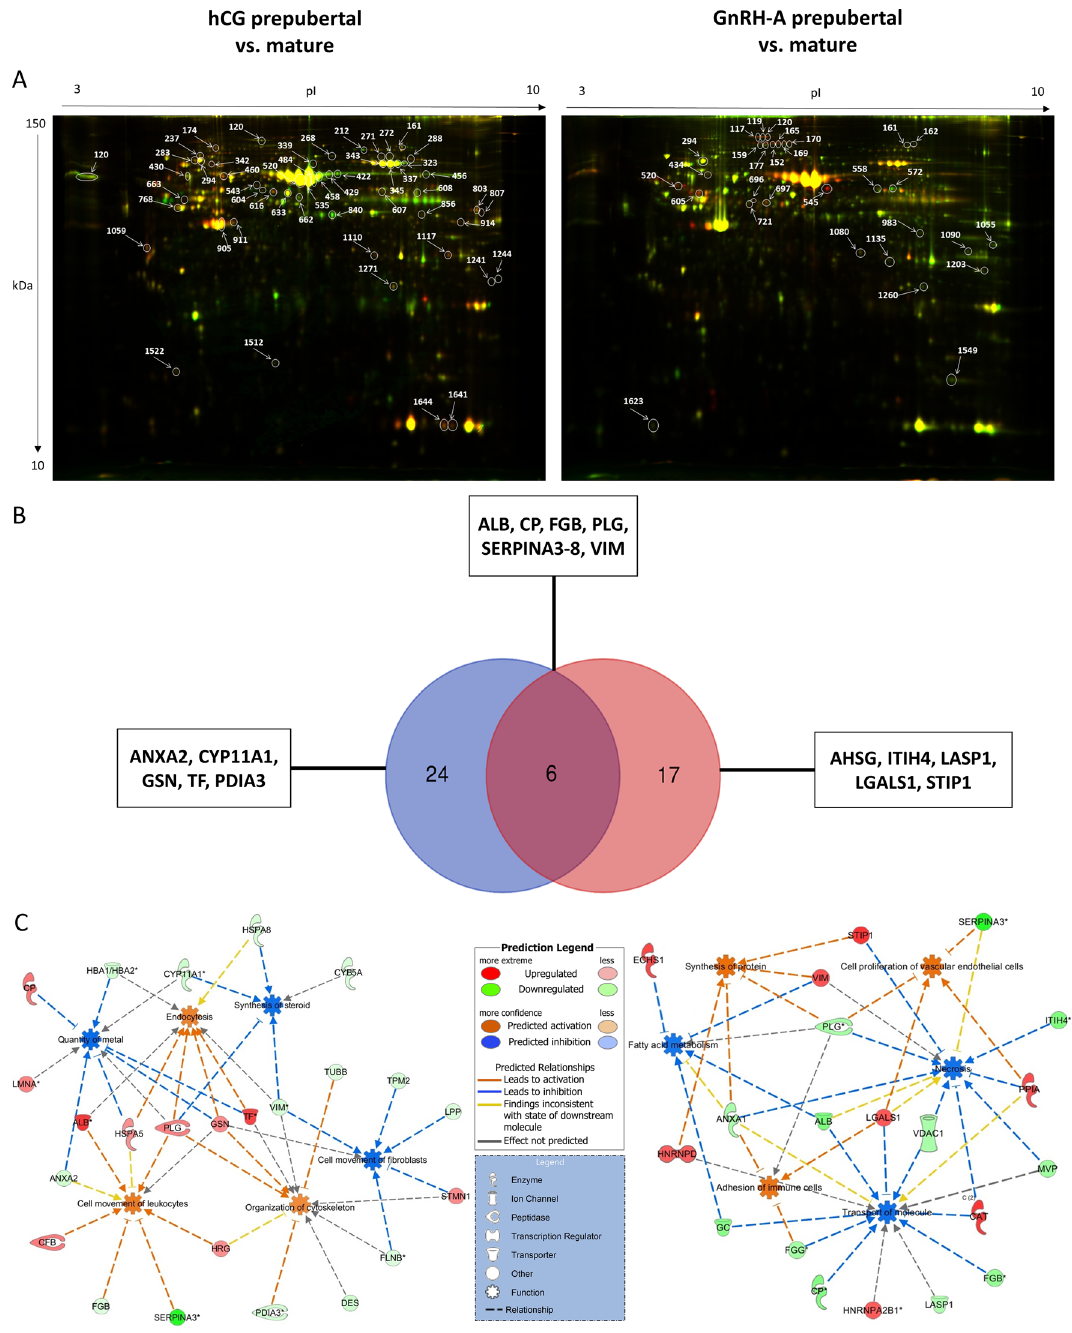
Figure 6. ( A ) Representative 2D-DIGE gel image of differentially abundant proteins in follicular walls of: (left panel) hCG-treated prepubertal (Cy3, green) vs. mature gilts (Cy5, red) and (right panel) GnRH-A-treated prepubertal (Cy3, green) vs. mature gilts (Cy5, red). Spot numbers correspond to the proteins which were identified by MALDI- TOF/TOF analysis. ( B ) Venn diagram shows hCG (blue) and GnRH-A (red) treatment affected proteins in prepubertal and mature gilts. ( C ) Molecular pathway enriched by differentially abundant proteins identified in follicular walls of treated gilts. Red and green colors depict an increase or decrease, respectively, in abundance of the proteins in follicular walls of treated gilts. The color intensity of nodes indicates a fold change increase or decrease associated with a particular protein. Direct and indirect interactions are indicated by solid, and dash lines,